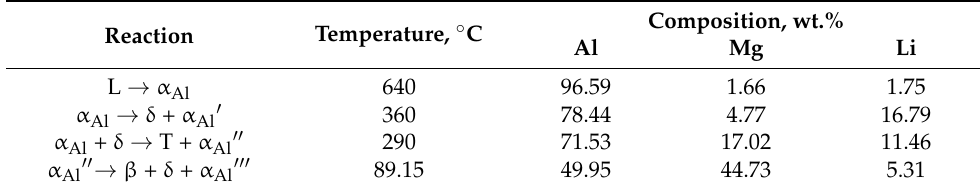
Figure 2. The equilibrium solidification sequence of the Al-2.18Mg-1.92Li alloy: ( a ) transformation of the α Al dendritic network and ( b ) solid-state diffusion processes in the α Al dendritic network. Abbreviations: the stable AlLi ( δ ), ternary Al 2 LiMg (T), and secondary eutectic Al 8 Mg 5 (β) phases. Table 2. The invariant reactions and corresponding temperatures for the Al-2.18Mg-1.92Li alloy equilibrium solidification sequence. Abbreviations: the stable AlLi (δ), ternary Al 2 LiMg (T), secondary eutectic Al 8 Mg 5 (β) phases, and liquid (L).